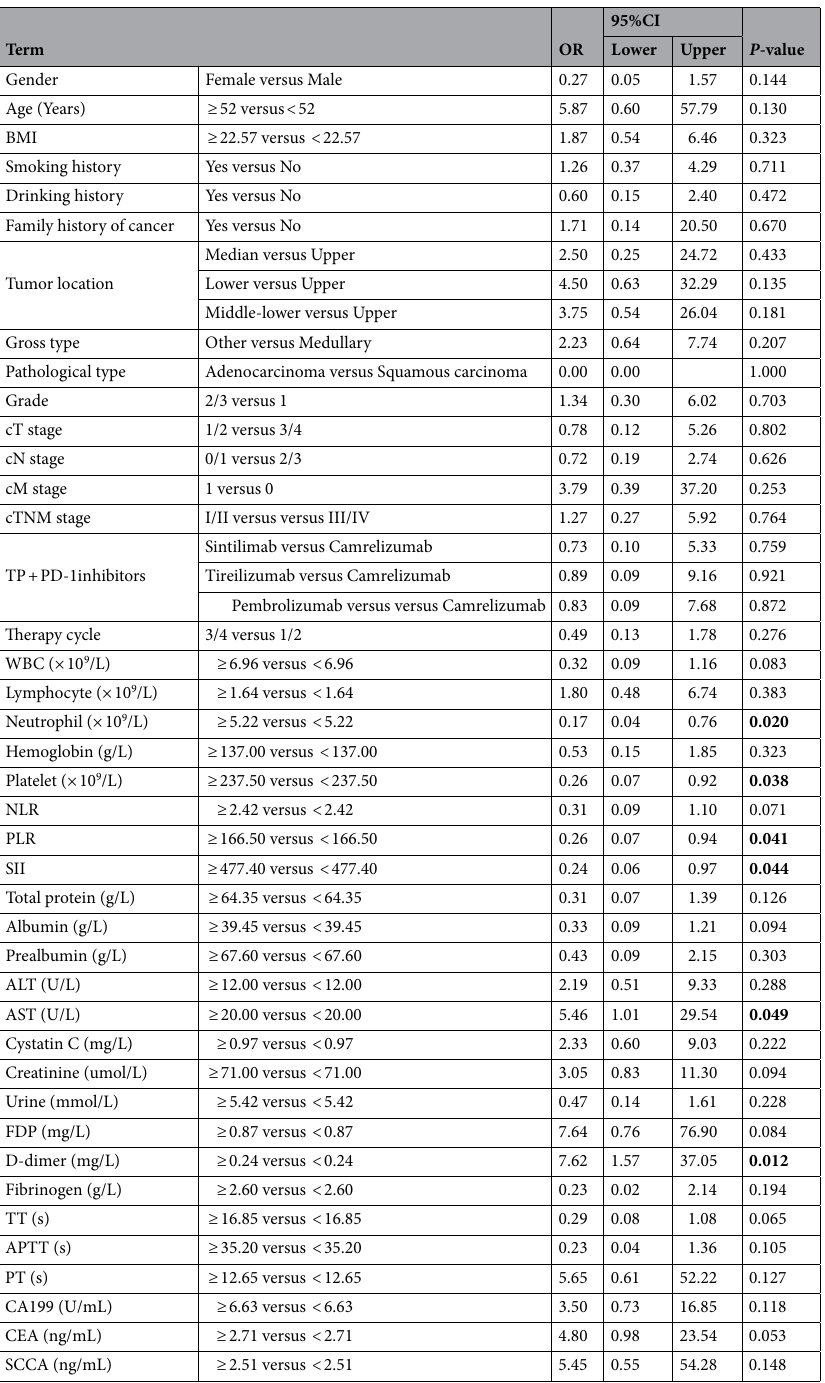
Table 3. Univariate logistic regression analysis of ORR in patients. ORR, objective response rate; OR, odds ratio; CI, confidence interval; BMI, body mass index; PD-1, programmed cell death protein-1; TP, platinum + taxol; WBC, white blood cell; NLR, neutrophil-to-lymphocytes ratio; PLR, platelet-to- lymphocyte ratio; SII, systemic immune-inflammation index; ALT, alanine aminotransferase; AST, aspartate aminotransferase; FDP, fibrin degradation product; TT, thrombin time; APTT, activated partial thromboplastin time; PT, prothrombin time; CA199, carbohydrate antigen199; CEA, carcinoembryonic antigen; SCCA, squamous cell carcinoma antigen. Significant values are in